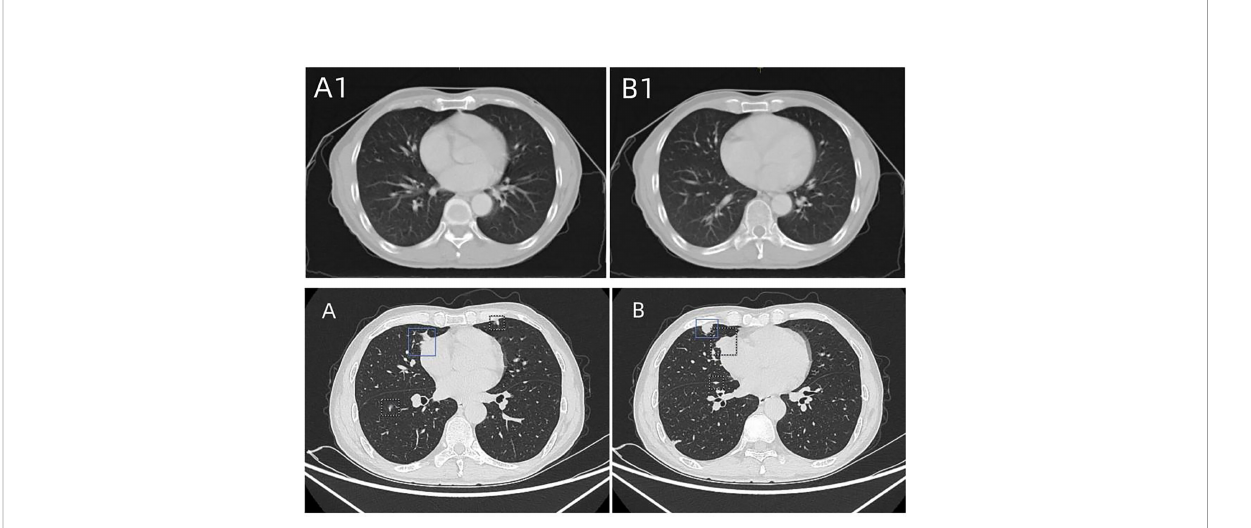
FIGURE 4 (A1, B1) Chest CT taken on October 29, 2021, before concurrent radiotherapy and chemotherapy. No obvious lung metastasis was found. (A, B) Chest CT taken on January 18, 2022, showing scattered nodules of different sizes in both lungs. The largest nodule was located near the heart border in the middle lobe of the right lung, which indicated pulmonary metastasis.